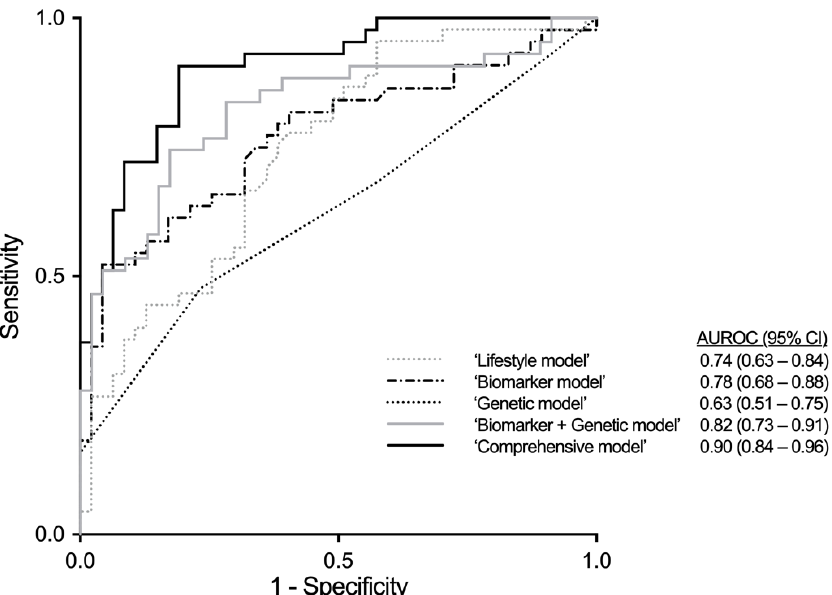
Figure 2. Receiver operating characteristic (ROC) curves of the multivariable models to predict NAFLD-fibrosis (F ≥ 1). The areas under ROC curves (AUROC) were 0.74 for the ‘Lifestyle model’ (including red meat intake, carbohydrate E% and unemployment), 0.78 for the ‘Biomarker model’ (including HbA 1c , insulin and triglycerides), 0.63 for the ‘Genetic model’ (including genetic risk score), 0.82 for the ‘Biomarker + Genetic model’ (including HbA 1c , insulin, triglycerides and genetic risk score) and 0.90 for the ‘Comprehensive model’ (including HbA 1c , triglycerides, moderate-to- vigorous physical activity time, red meat intake, carbohydrate E%, smoking and genetic risk score). Abbreviations: AUROC, area under receiver operating characteristic curve; CI, confidence interval.